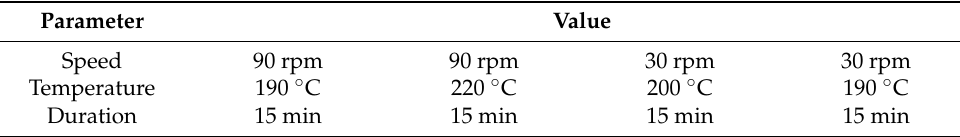
Table 2. Parameter settings for melt